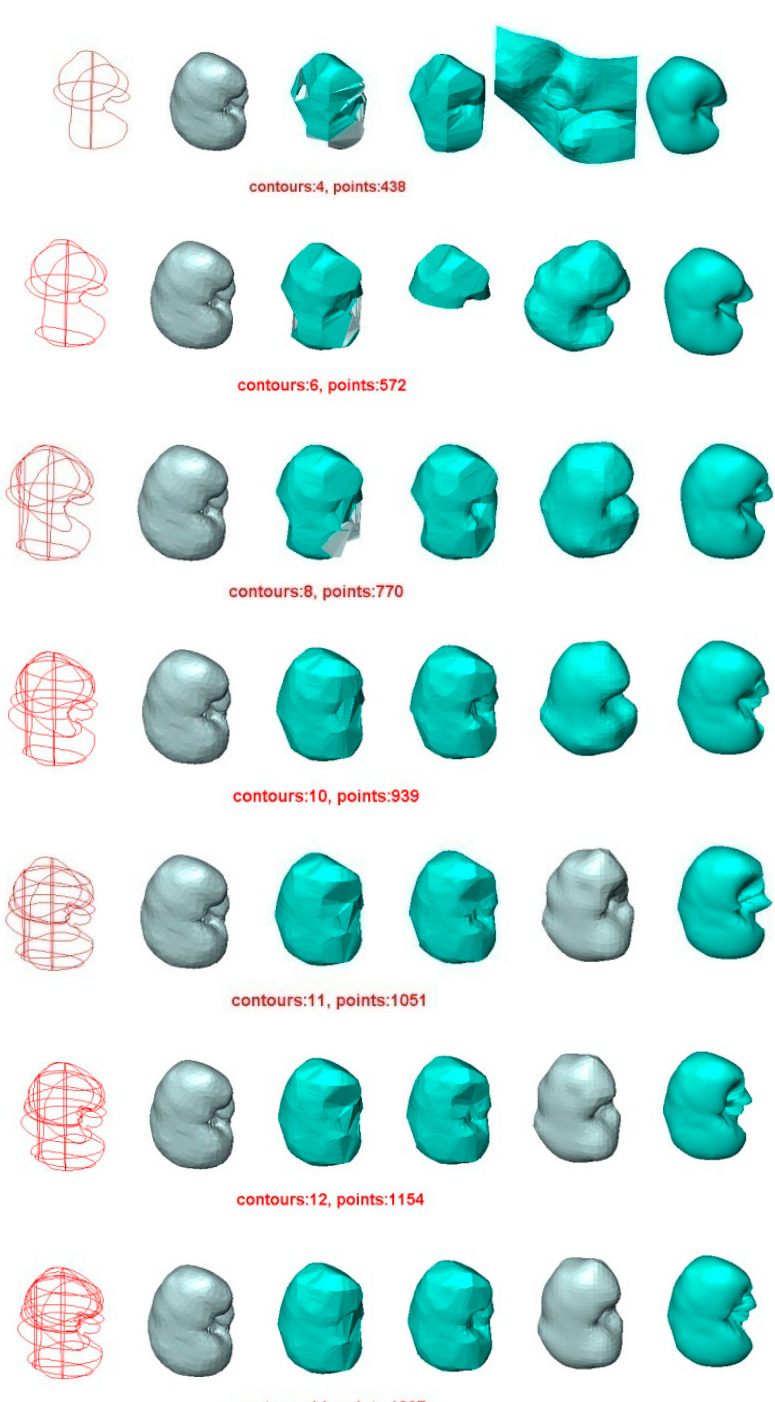
Figure 6. Surface reconstruction of a human kidney by four methods. For each row, from left to right: the contours used, the original surface, the surface reconstructed by BPA, the surface reconstructed by Power Crust, the surface reconstructed by Poisson, and the surface reconstructed by VSR.